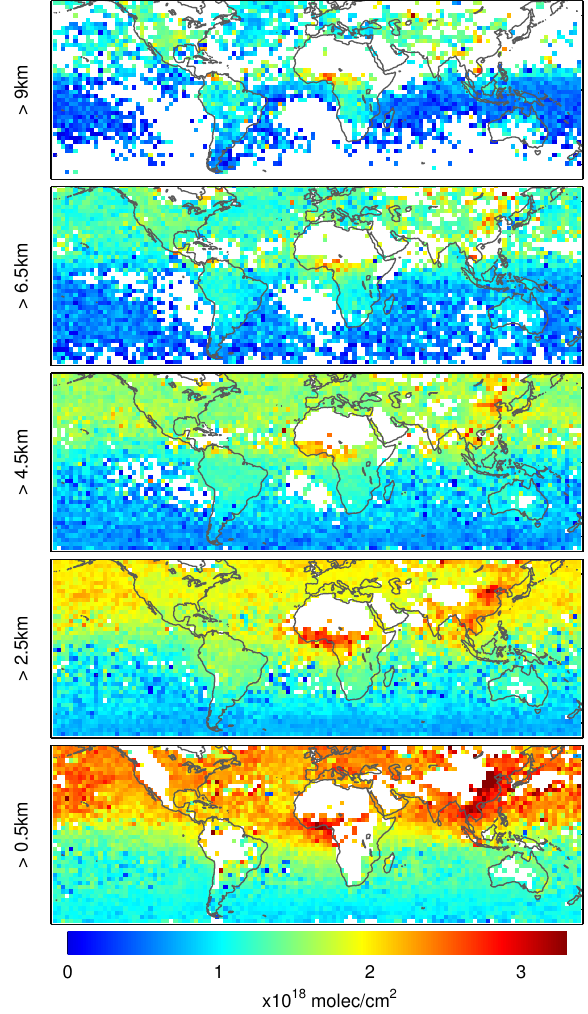
Fig. 3. CO PVCDs for different cloud heights derived from SCIA- MACHY measurements from January to March 2003–2005 (mea- surements with CRF >30%). Gaps are caused by missing measure- ments or low number of measurements (e.g. over desert regions and high mountains).